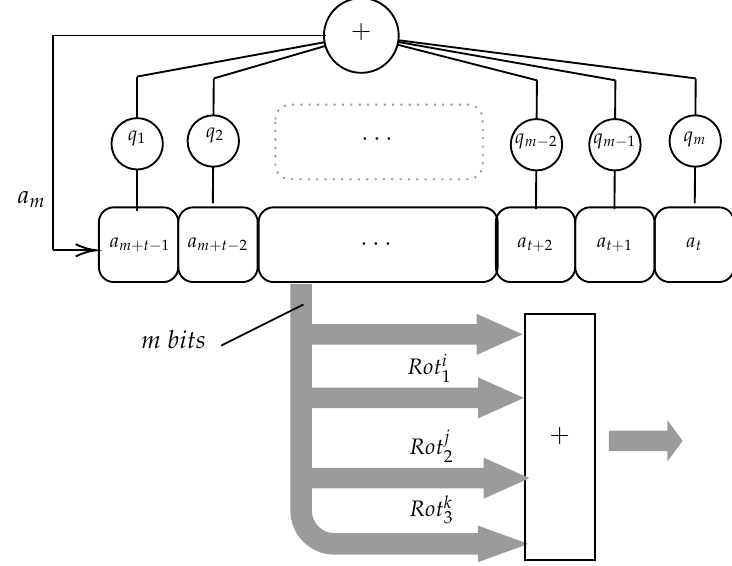
Figure 3. Gaussian generator based on LFSR